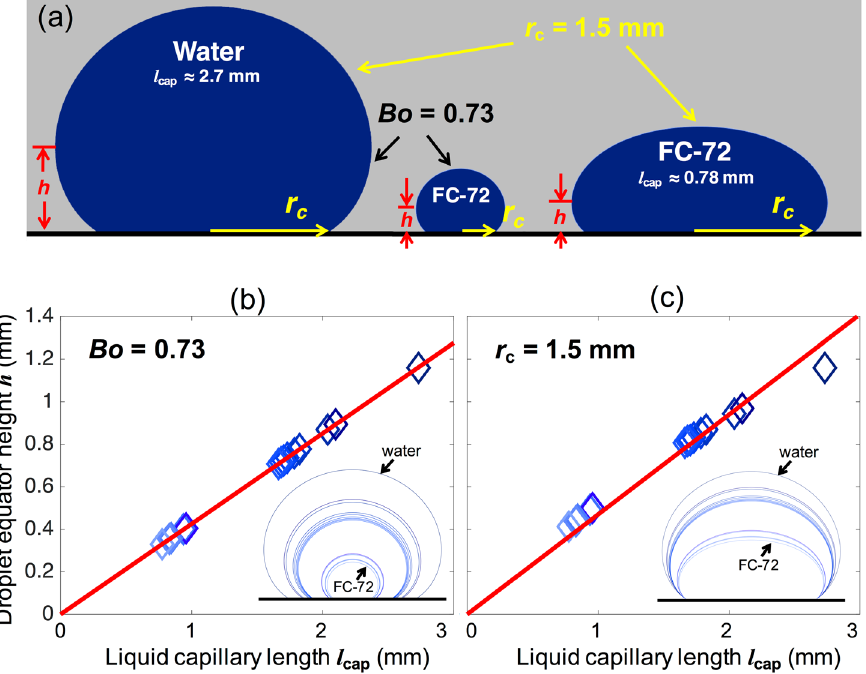
Figure 2. Sessile drops of two liquids with very different capillary lengths l cap and same large contact angle. ( a ) Droplet profiles of water and FC-72 drawn from numerical integration with apparent contact angle θ * = 150°. Comparing the water droplet and the small FC-72 droplet in the middle, they share the same Bond number ( Bo = 0.73) and thus the same profile shapes, but the FC-72 droplet is smaller due to its smaller l cap . Comparing the water droplet and the large FC-72 droplet on the right, they share the same contact radius ( r c = 1.5 mm), but the FC-72 droplet is flattened more due to its smaller l cap . Now, comparing the two FC-72 droplets, notice their equator heights h are similar despite a large difference in their volumes. This departure between h , which determines the image resolution, and the droplet size, which is commonly used to decide the resolution, leads to the common inaccuracy, which we propose to correct. ( b and c ) Relation between h and l cap from the theoretical profiles of 13 different liquids selected for experiments in this paper. The red lines show the linear fitting. The insets show the droplet profiles under their respective boundary conditions. In ( b ), water and FC-72 are compared with Bo = 0.73, i.e., the left and middle droplets in ( a ), over 0.42 mm < r c < 1.5 mm. In ( c ), water and FC-72 are compared with r c = 1.5 mm, i.e., the left and right droplets in ( a ), over 0.73 ≤ Bo ≤